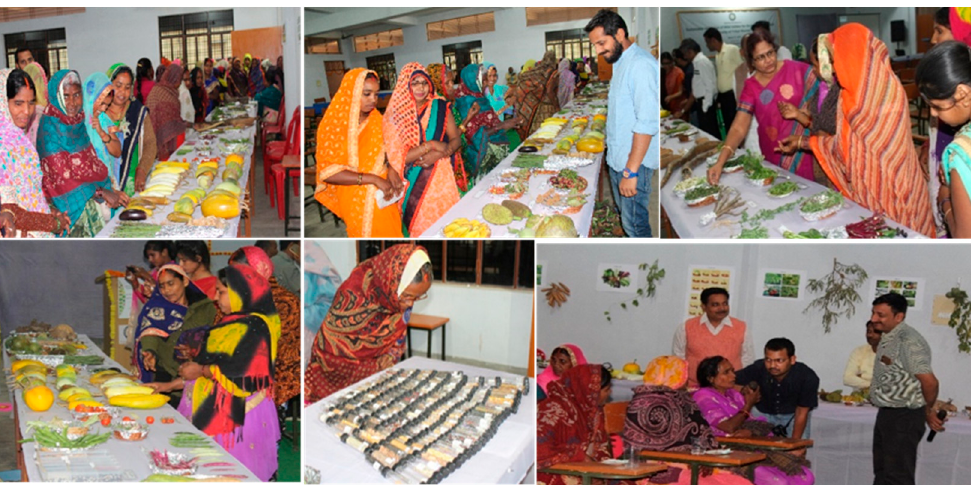
Figure 7. Popularization of neglected and wild edibles among diverse stakeholders especially women is important for dietary diversification program and thereby attaining food and nutritional